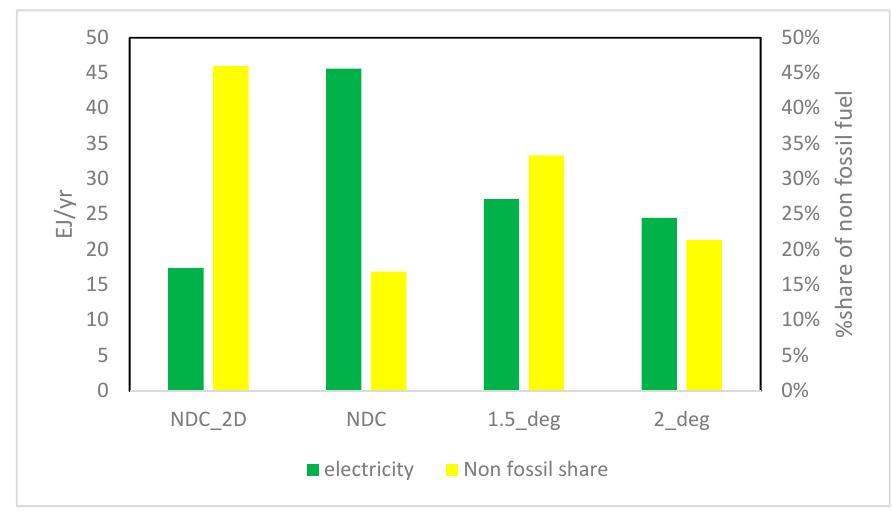
Figure 5. Total electricity generation and share of non-fossil fuel (%) in different scenarios in 2050.